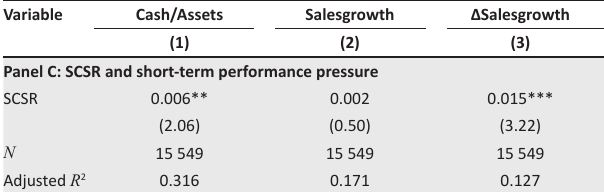
TABLE 5C: Further analyses.